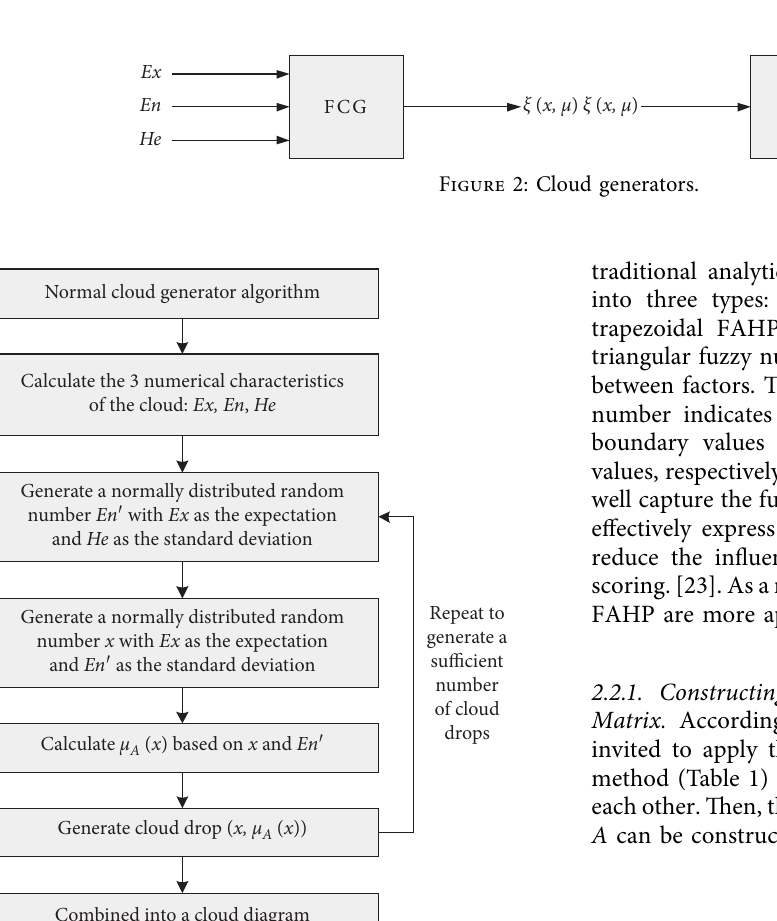
Figure 1: A normal cloud and its numerical characteristics.